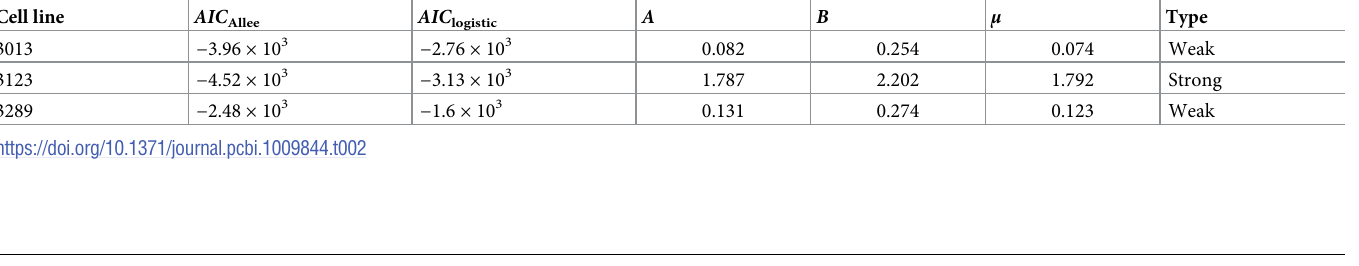
= 1.6 × 10 − 10 cm 2 /s. All other c